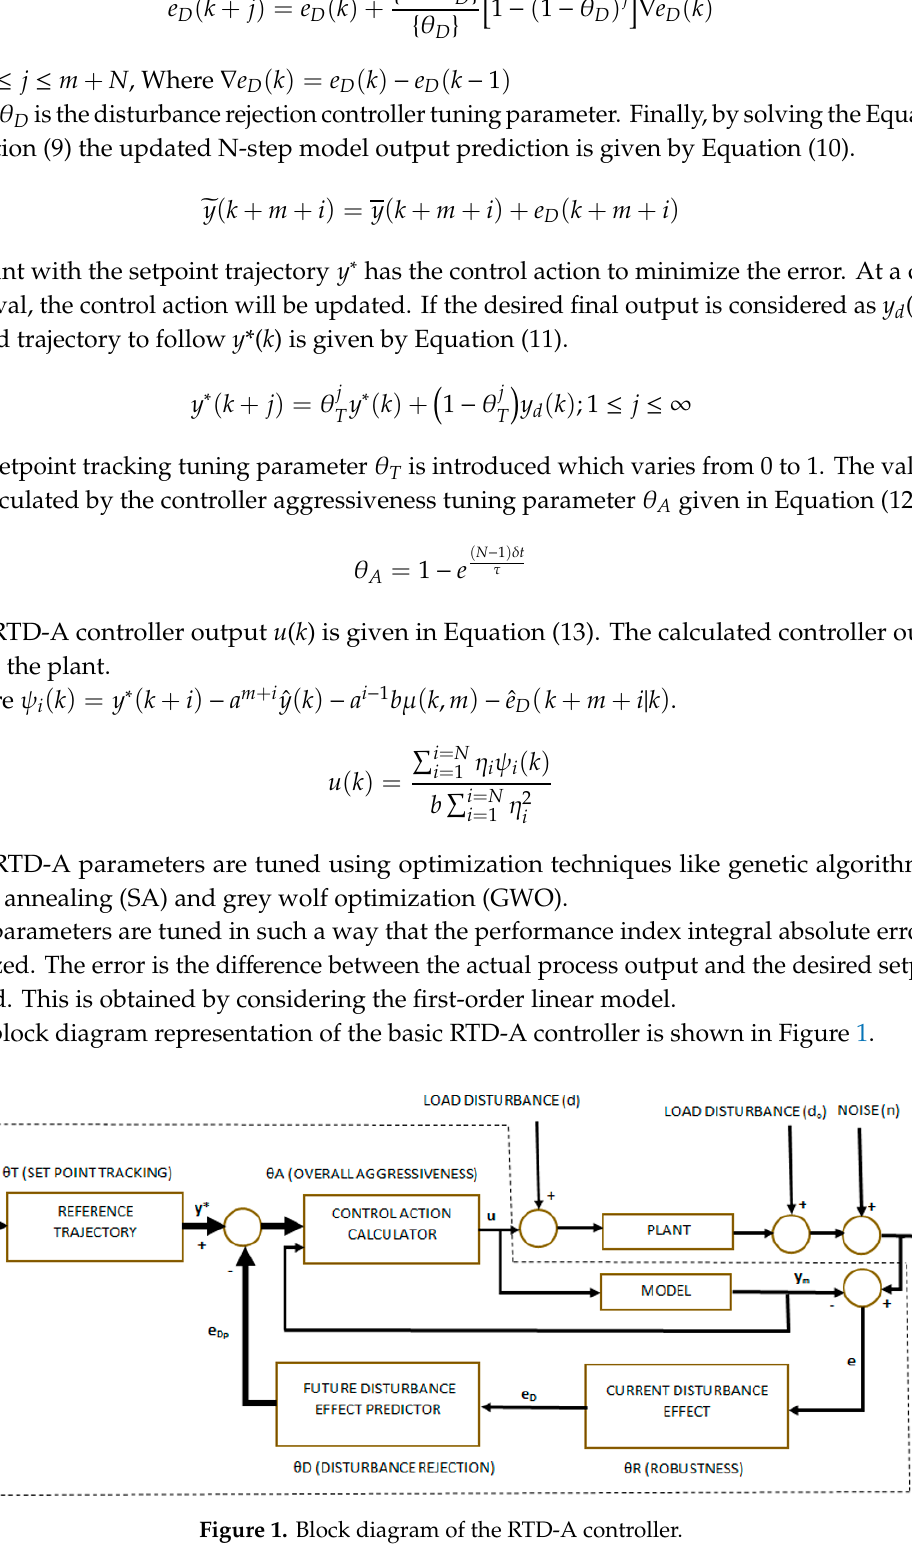
Figure 1. Block diagram of the RTD-A controller.